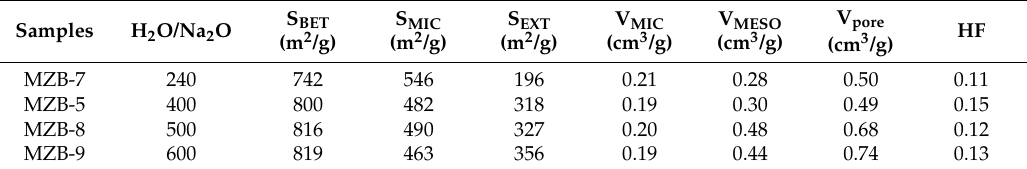
Table 2. Pore structure parameters of hierarchical Beta zeolites with different H2O amounts.